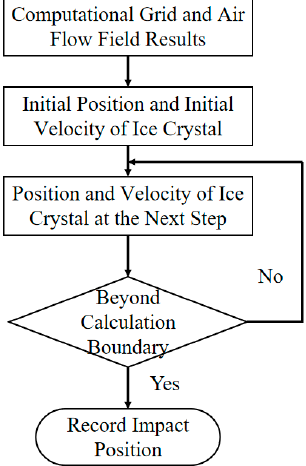
Figure 1. Flowchart of ice crystal motion trajectory calculation.